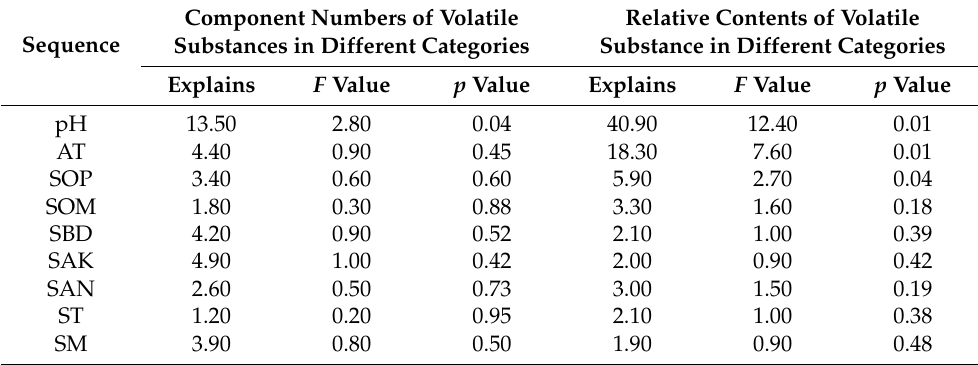
Table 3. The results of redundancy analysis (RDA) on the component numbers and relative contents of volatile substances in different categories and soil properties under different cultivation patterns.